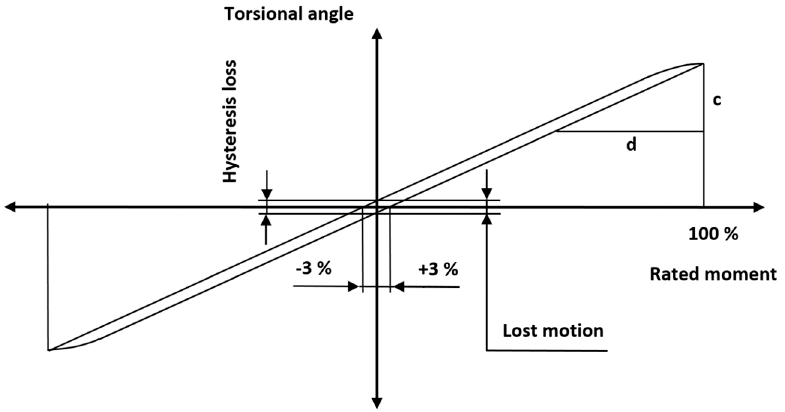
Figure 3. Dead zone definition based on the hysteresis curve.